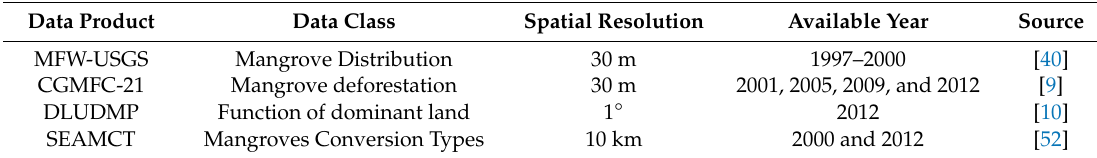
Table 1. Product specifications of mangrove data and their